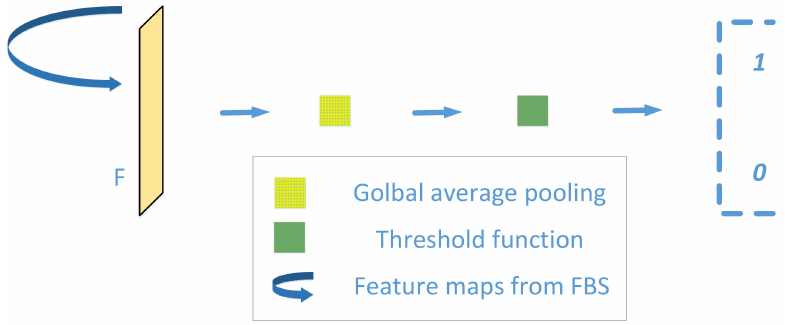
Figure 7. Classification